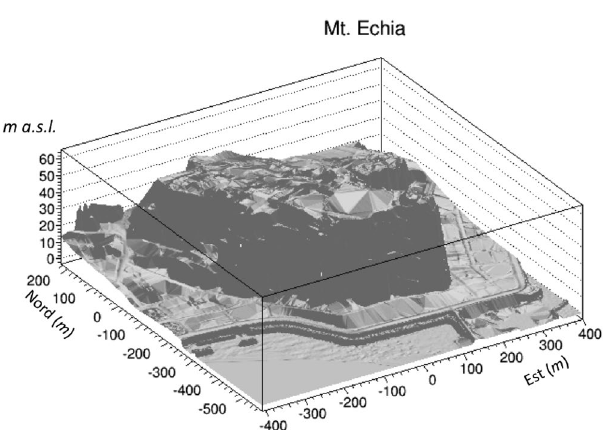
Figure 1. Digital Terrain Model (DTM) of Mt. Echia, with a resolution of 1 m in the horizontal x-y coordinates and 10 cm in the vertical z coordinate. The detector is located at 10 m a.s.l. within the dashed square, in the neighbourhood of the Bourbon Tunnel (straight line). The main underground structures located in the surrounding area are schematically shown. The map has been obtained by LIDAR observations elaborated by the following softwares: Terrasolid - Terrascan, LP360, RIEGL Riscan Pro, Golden Software - Surfer 12 and root .